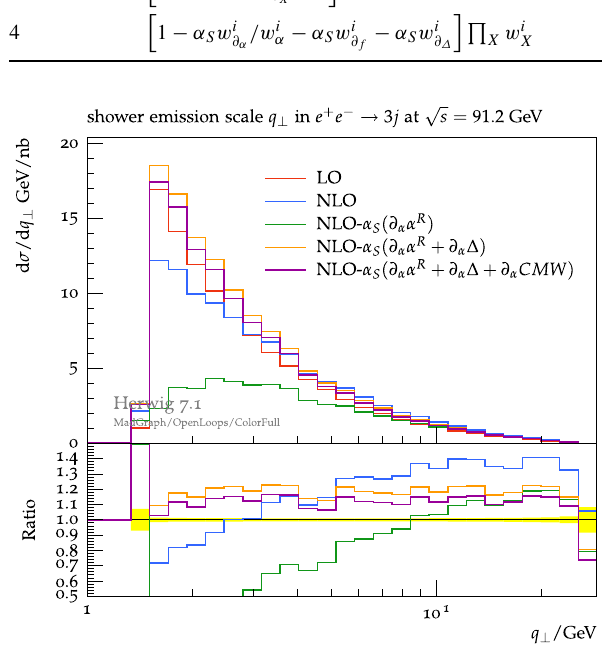
Fig. 3 NLO corrections and shower expansion terms in the case of the shower emission scale in e + e − to jets events. See text for details